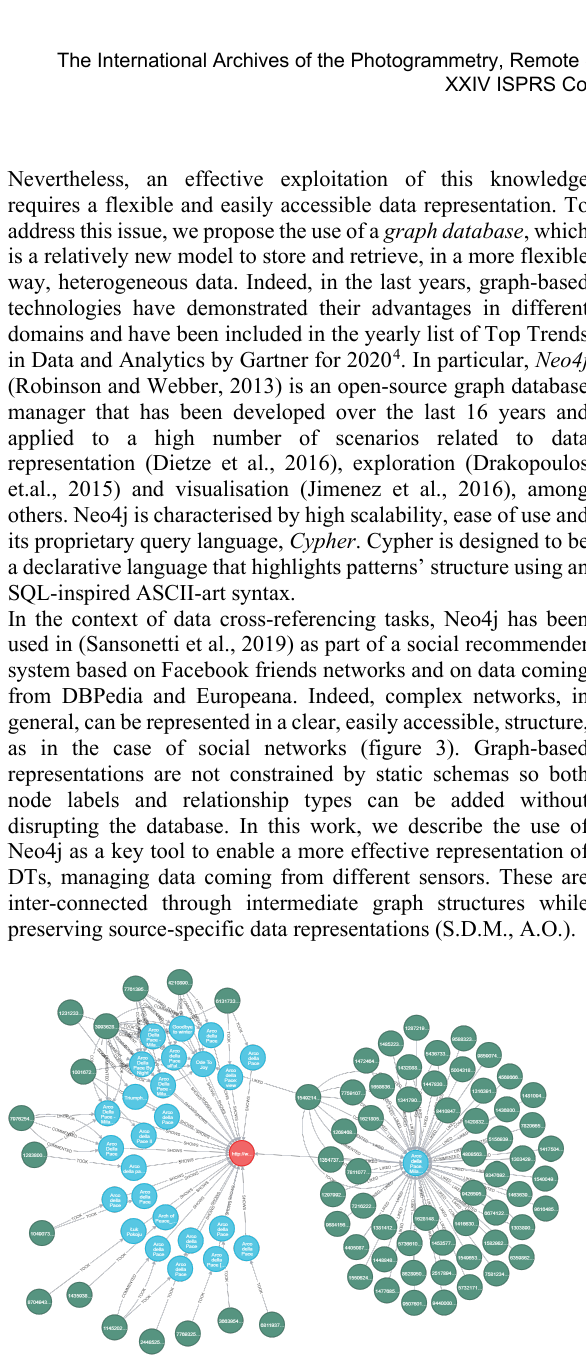
Figure 3 . Graph representation of the social activity extracted from Flickr with respect to the Wikidata object representing the Arco della Pace .